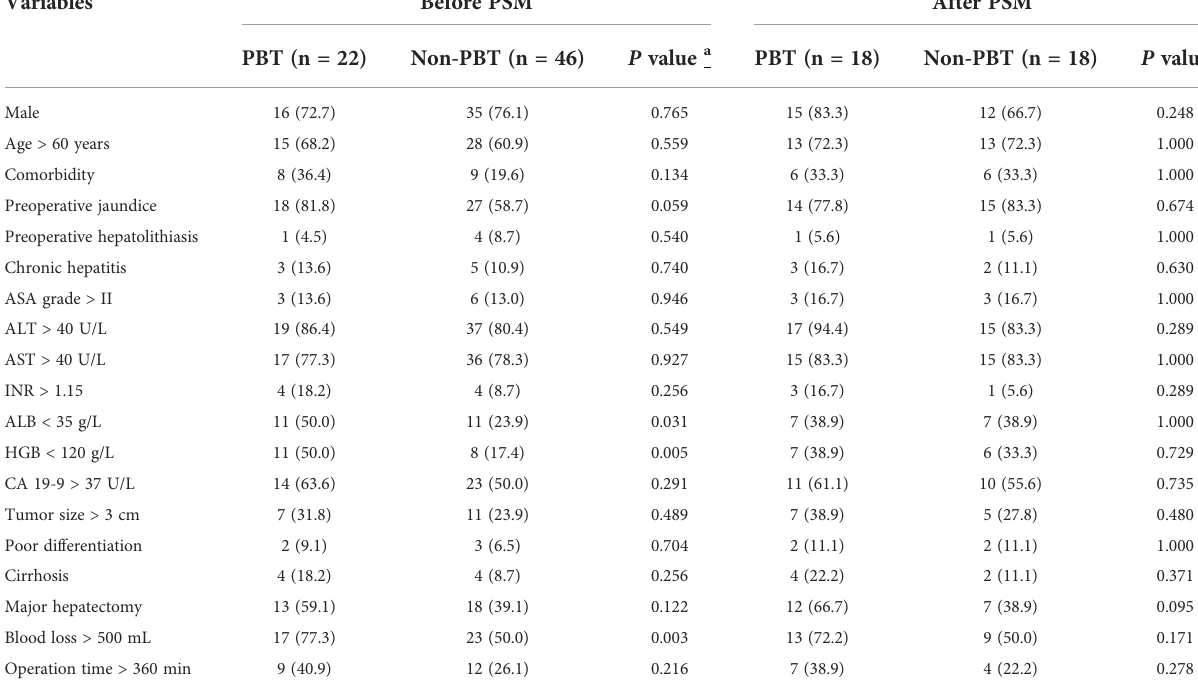
TABLE 2 Clinicopathologic characteristics of the PBT and non-PBT groups among patients with early stage (8th AJCC stage I) pCCA treated with curative resection.